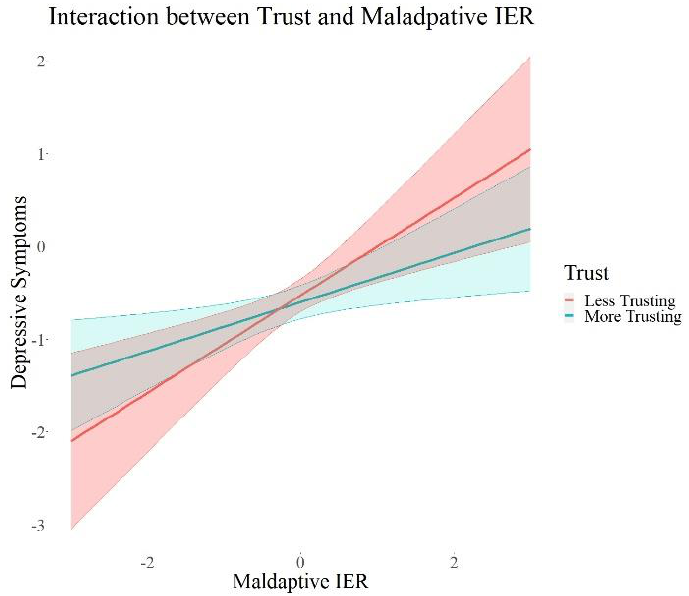
Figure 6. Interaction Effects between Trust and Maladaptive IER on Depressive Symptoms. Note. The shades behind the thicker lines represent the 95% confidence interval. All variables were standardized, and the scales on the graph represent standard deviations (i.e., 2 = 2 units of standard deviation).